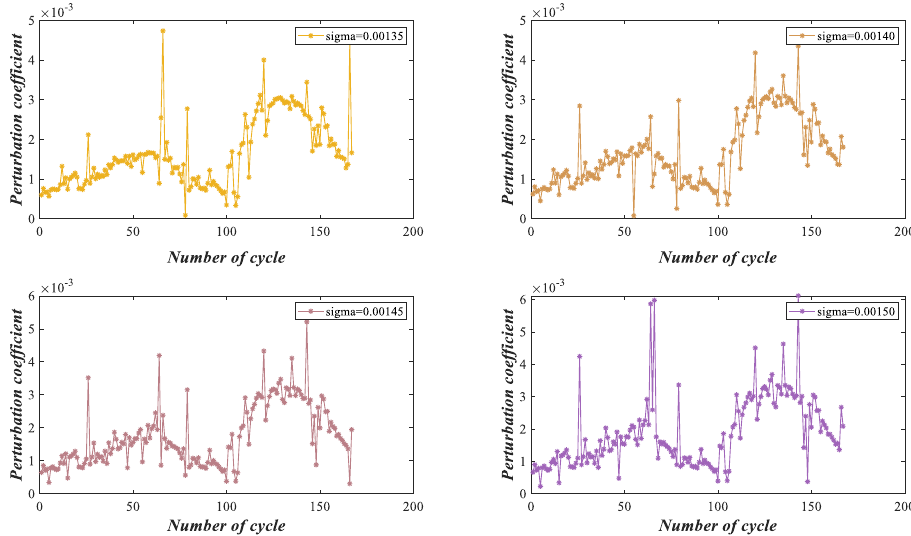
Figure 12. Perturbation coefficients at various perturbation intensities.